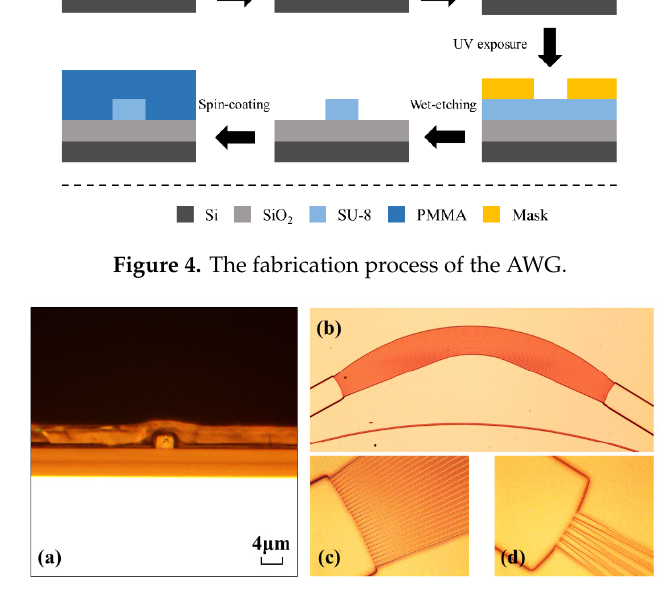
Figure 5. The micrographs of the fabricated AWG: ( a ) the crossing diagram, ( b ) the overall structure diagram and ( c,d ) partial enlarged diagram of the fabricated AWG.